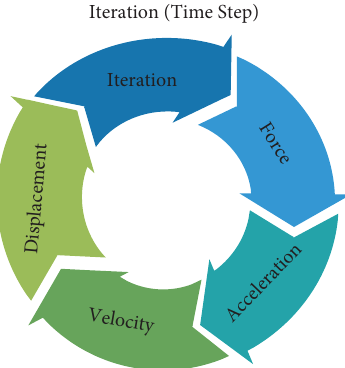
Figure 3: Time step iteration loop.